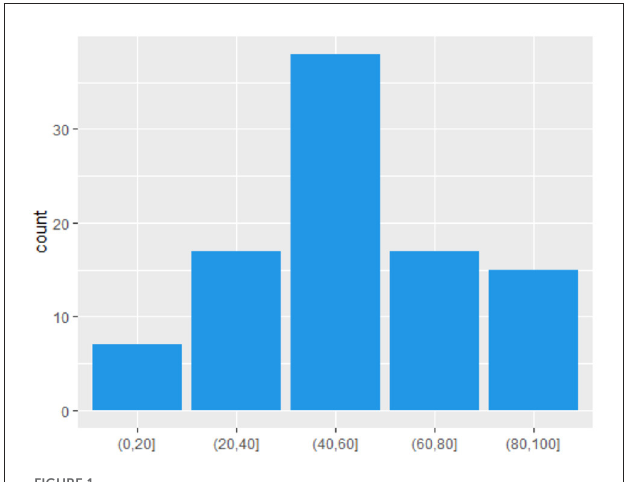
FIGURE1 Score distribution of fidelity in five levels of performance.